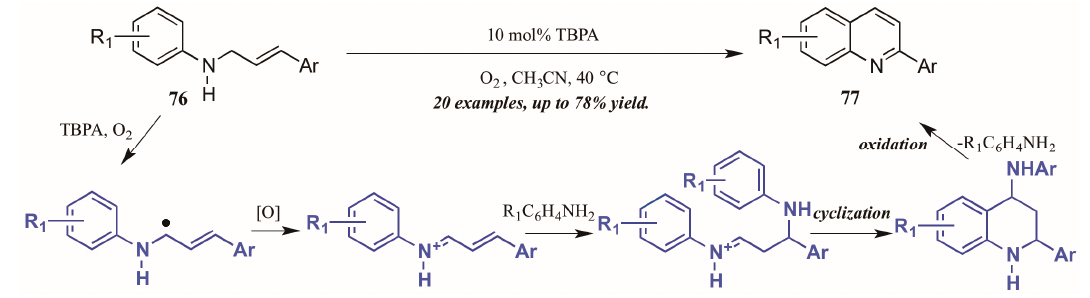
Figure 34. Radical cation-catalyzed intramolecular oxidative cyclization.